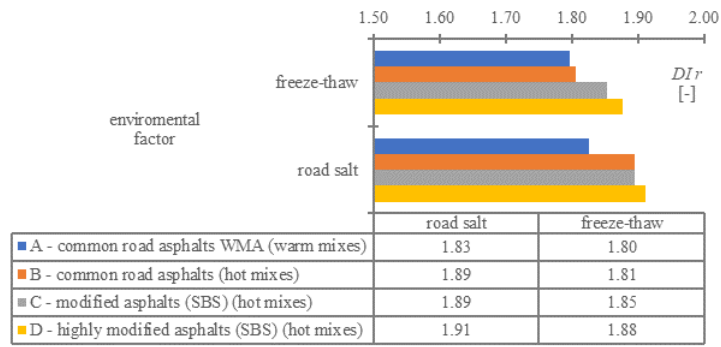
Figure 12. Degradation ratio (DI r) considering stiffness changes in the mix.